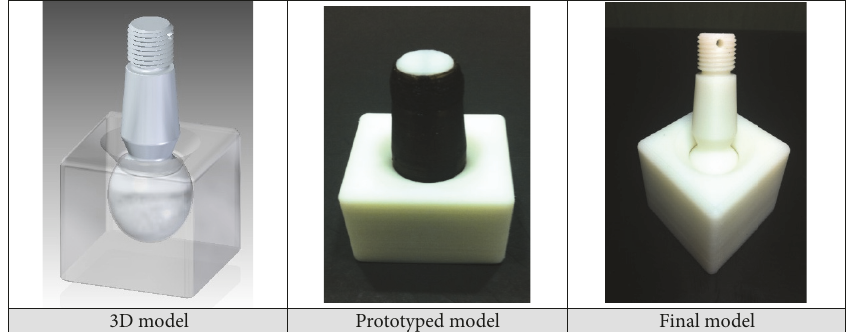
Figure 1: Ball joint mounted in its housing